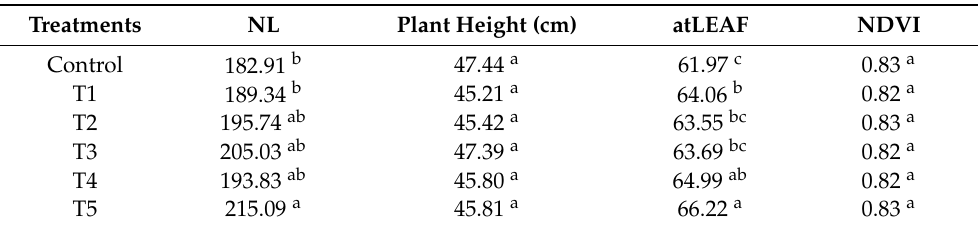
Table 2. Number of leaves (NL) , plant height, relative chlorophyll content (atLEAF), and normalized difference vegetation index (NDVI) of cocoplum grown in different fertilization rate. Treatments NL Plant Height (cm) atLEAF NDVI Control 182.91